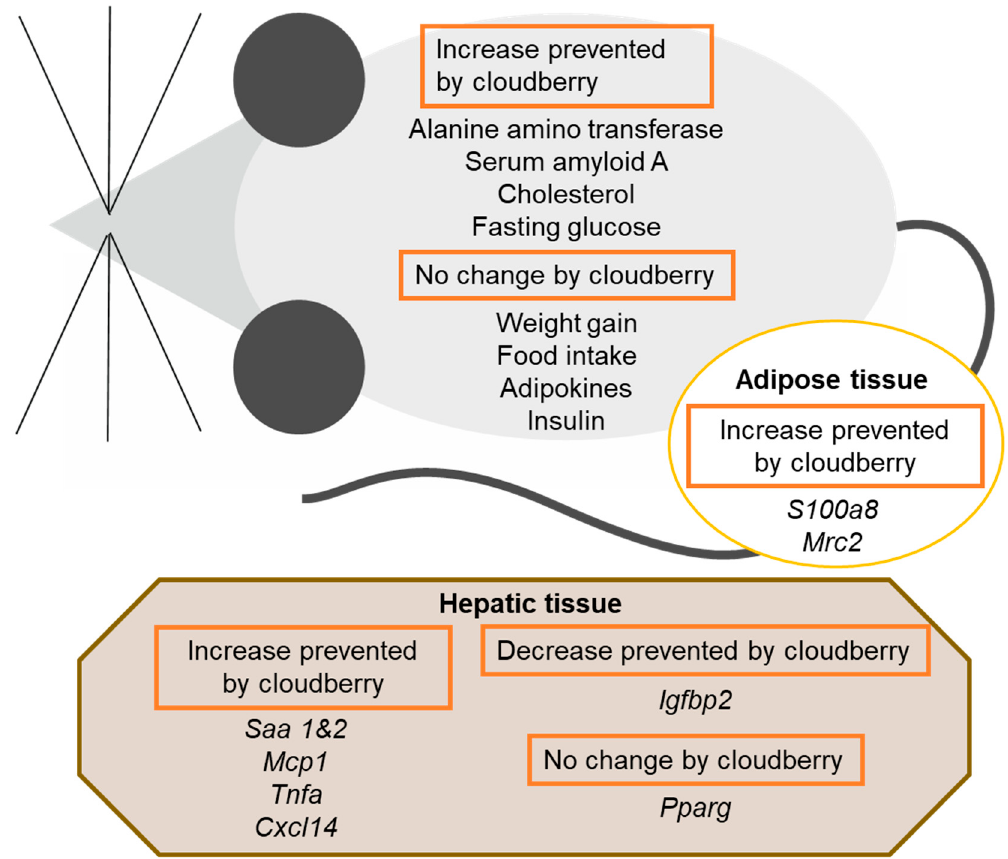
Figure 7. Summary of the results. Weight gain, food intake, biomarkers measured in serum, and gene expression in hepatic and adipose tissues. Saa = serum amyloid A; Cxcl14 = chemokine (C-X-C) motif ligand 14; Igfbp2 = insulin-like growth factor binding protein 2; Mcp1 = monocyte chemoattractant protein 1; Mrc2 = mannose receptor C type 2; Pparg = peroxisome proliferator-activated receptor γ ; S100a8 = S100 calcium-binding protein A; Tnfa = tumor necrosis factor α .